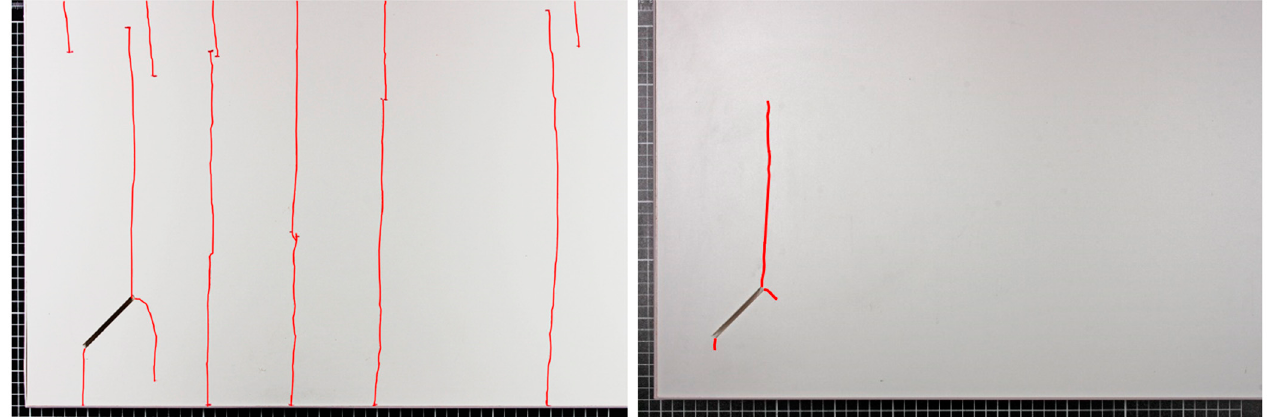
Figure 6. Cracking pattern of laminate L6 ( left ) and laminate L 35 ( right ). The cracks are highlighted with a red marker (the length of the slits is 5 cm).